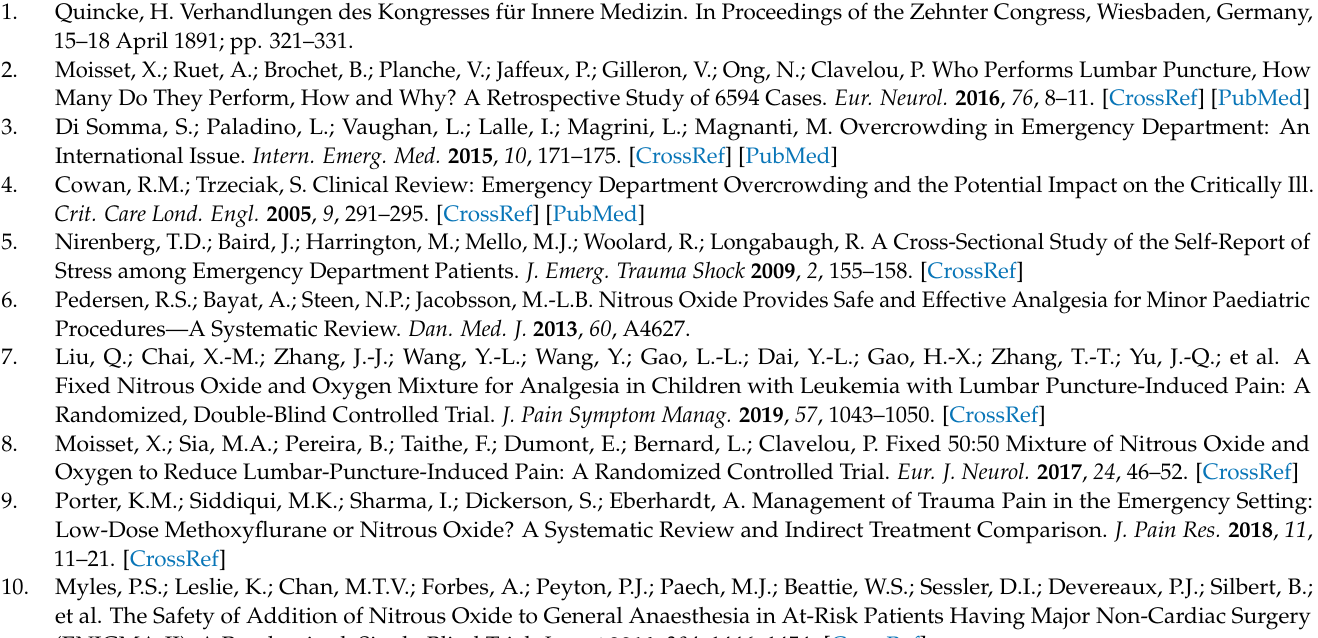
Table S2: Summary of results concerning pain, anxiety, and patient satisfaction (per protocol